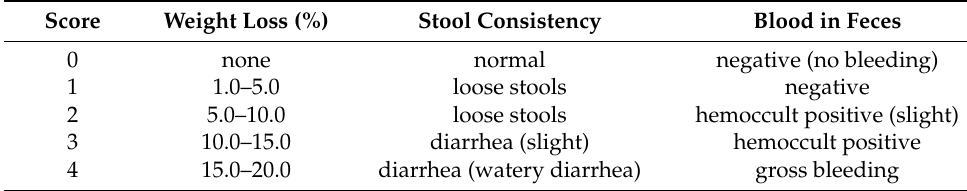
Table 2. Calculated disease activity index (DAI)